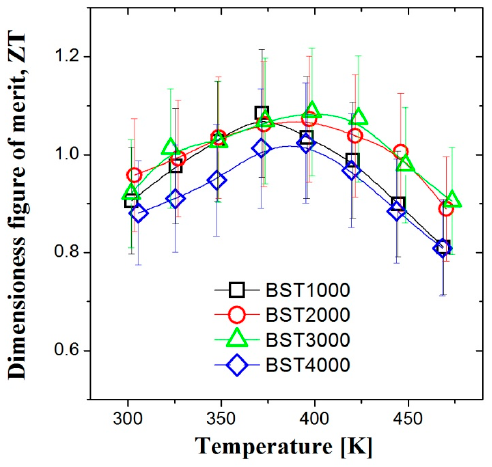
Figure 7. Temperature dependence of the dimensionless figure of merit ( ZT ) for BST1000–BST4000 samples.